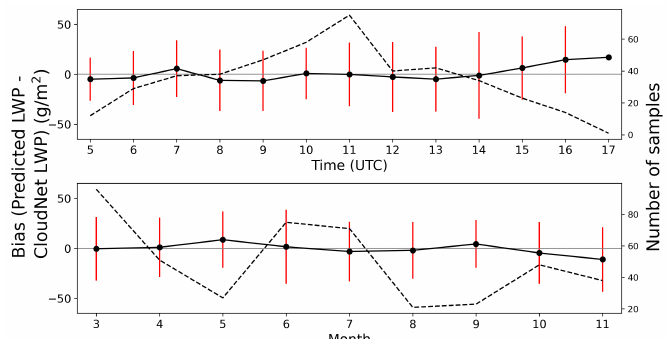
Figure 6. Time-dependent error plots as a function of hours ( top ) and months ( bottom ) for test data for homogeneous without feature selection in Leipzig. The black lines are means of the bias between LWP retrieved by the GBRT model and CloudNet LWP with one standard deviation as the red vertical line. The black dashed lines indicate the number of